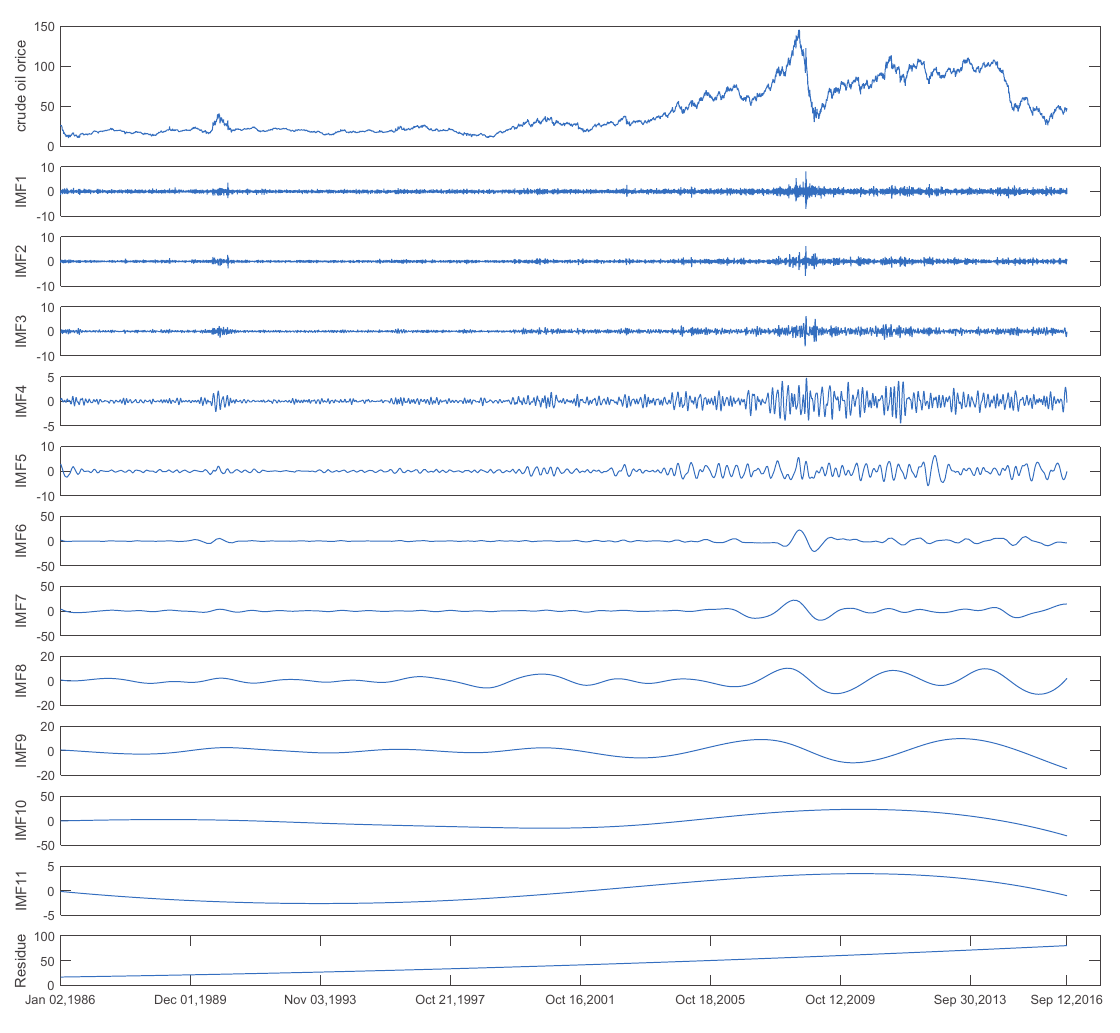
Figure 2. The IMF and residue components by